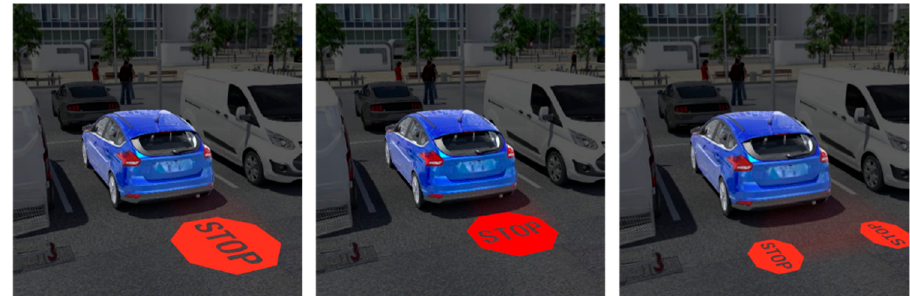
Figure 3. Graphics from three Message Interpretation items. Each item’s question read: “You are a pedestrian walking through a parking lot. An autonomous car is projecting this graphic behind it. What does the graphic mean to you?”.